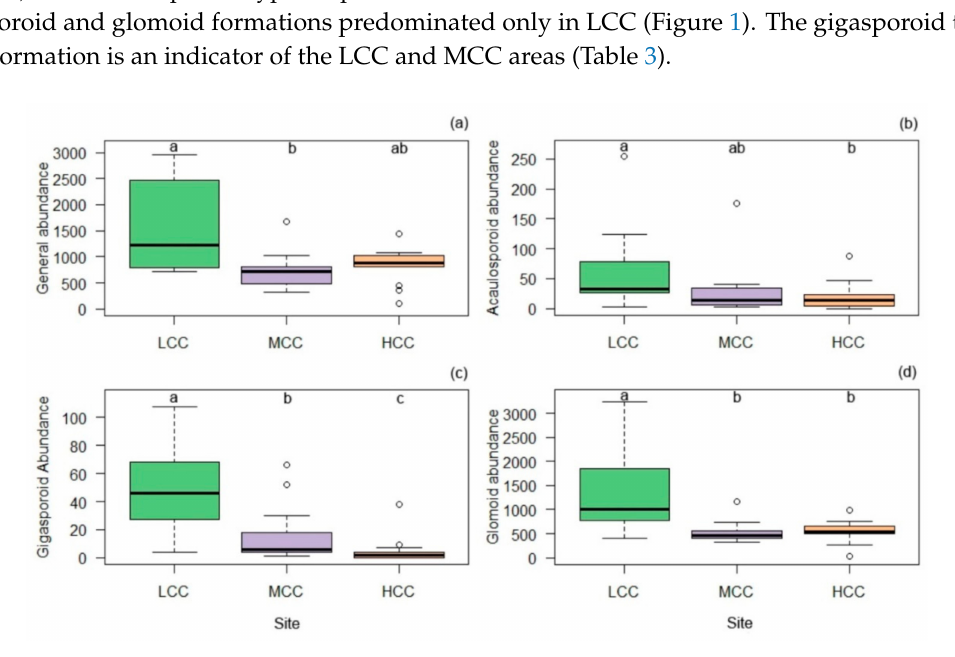
Figure 1. Overall number of spores ( a ) and by spore-formation type: acaulosporoid ( b ), gigasporoid ( c ) and glomoid ( d ) soil in three areas with clay gradient (LCC: Low Clay Content, MCC: Medium Clay Content, HCC: High Clay Content). Bars followed by the same letter do not di ff er